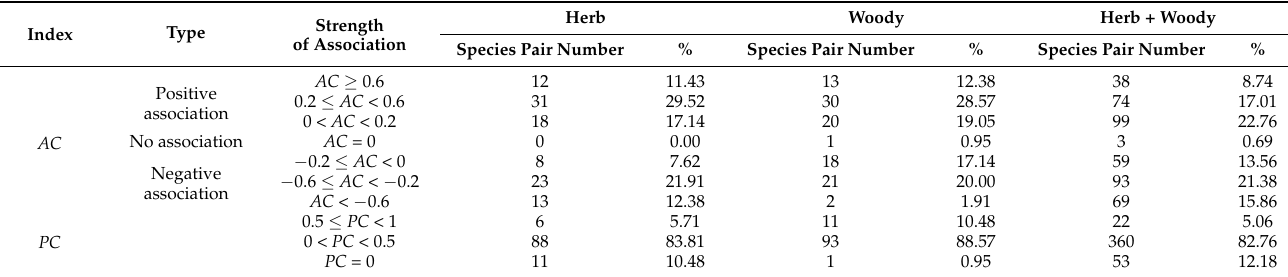
Figure 4. Interspecific associations strength. Lower is AC values, upper is PC values. The numbers represent the plants in Table 1. The larger the circle, the redder the color and the larger the value; the smaller the circle, the bluer the color and the smaller the value. Table 5. Interspecific associations strength analysis among the 30 species at the Ziwuling study area on the Chinese Loess